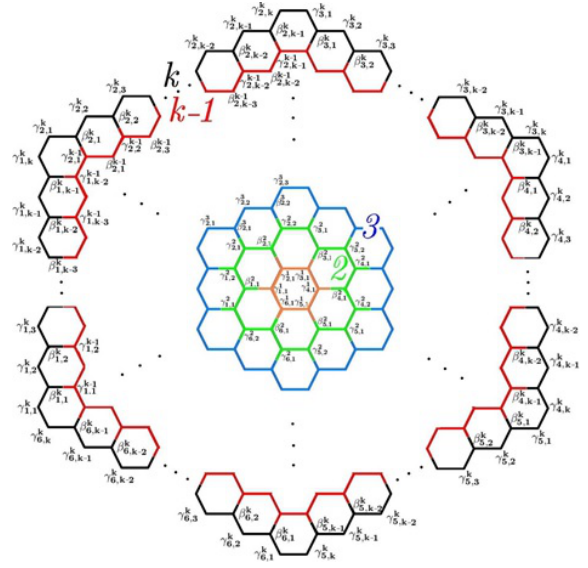
Fig. 2 Another representation of Polycyclic Aromatic Hydrocarbons